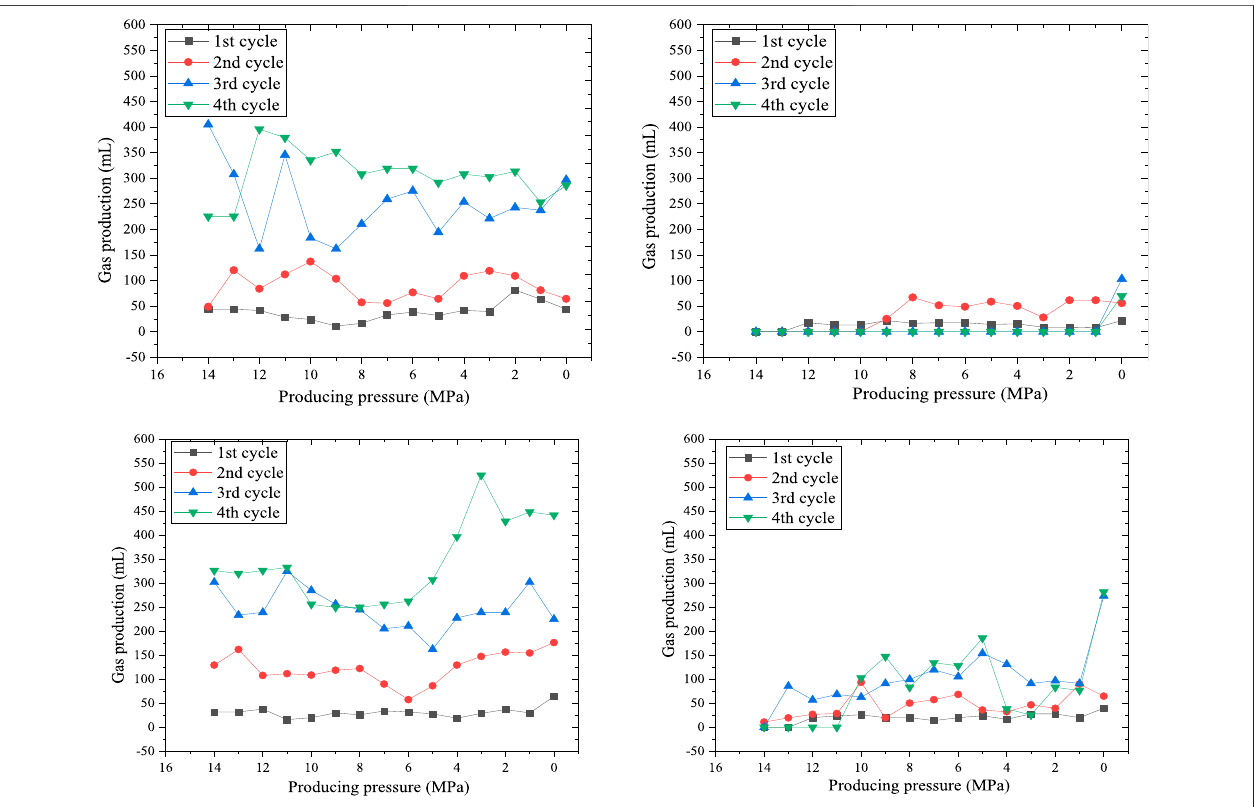
FIGURE 13 | Gas production for each cycle of dual sandpack. (A) High permeability sandpack of N 2 huff-n-puff. (B) Low permeability sandpack of N 2 huff-n-puff. (C) High permeability sandpack of N 2 huff-n-puff assisted by viscosity reducer. (D) Low permeability sandpack of N 2 huff-n-puff assisted by viscosity reducer.